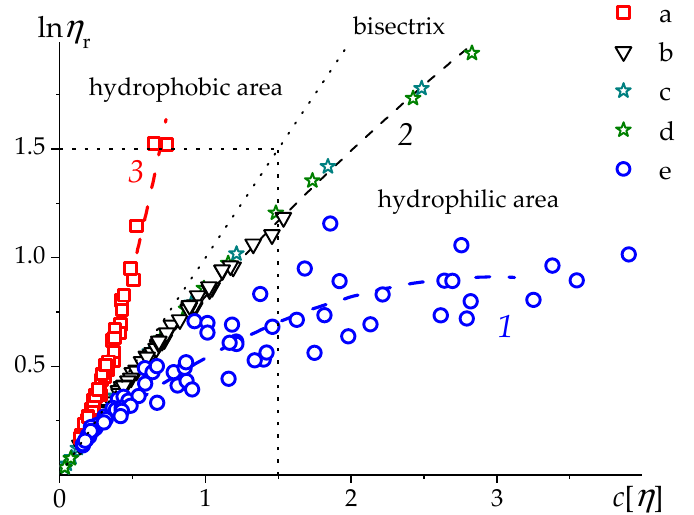
Figure 5. The dependence of natural logarithm of relative viscosity ln η r vs. c [ η ] resolved for PSSNa in aqueous solutions of different ionic strength [54,59] (a—4.17 M NaCl, B 2 = ( 2.9 ± 0.6 ) ; b—0.2 M NaCl, B 2 = − ( 0.043 ± 0.002 ) , and e—H 2 O, B 2 = − ( 1.4 ± 0.4 ) ) and polystyrene (PS) in toluene, B 2 = − ( 0.12 ± 0.01 ) [52] (c and d—samples with M = 146,000 and 600,000 g/mol, correspondingly). Dashed line represents the bisectrix (i.e., line ln η r = c [ η ] ) of current coordinates, 1—is extrapolation of PSSNa data in H 2 O (e), 2—PSSNa in aqueous 0.2 M NaCl (b), PS in toluene (c and d), and 3—PSSNa in aqueous 4.17 M NaCl (a).